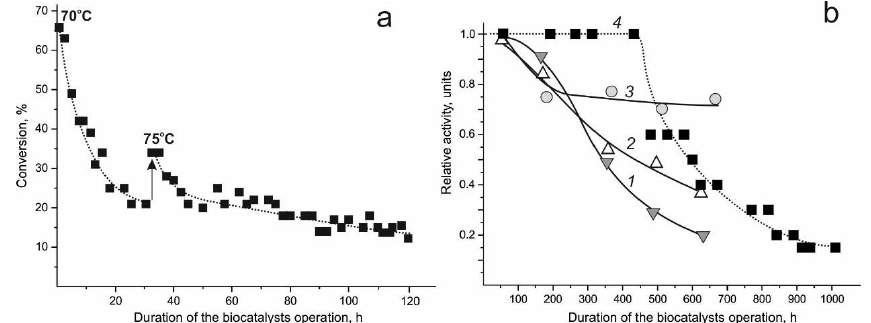
Figure 8. Operational stability of r E. coli /lip lysate-based biocatalysts in the processes: ( a ) Continuous/ periodic interesterification of oil-fat blends at 70–75 ◦ C; the biocatalyst composition, in w / w %: r E. coli /lip lysate—37–38, maltodextrin—10, SiO 2 —till 100. ( b ) Periodic interesterification of sunflower oils with ethyl acetate at 40 ◦ C; the biocatalyst composition, in w / w %: r E. coli /lip lysate—25–28, maltodextrin—10,